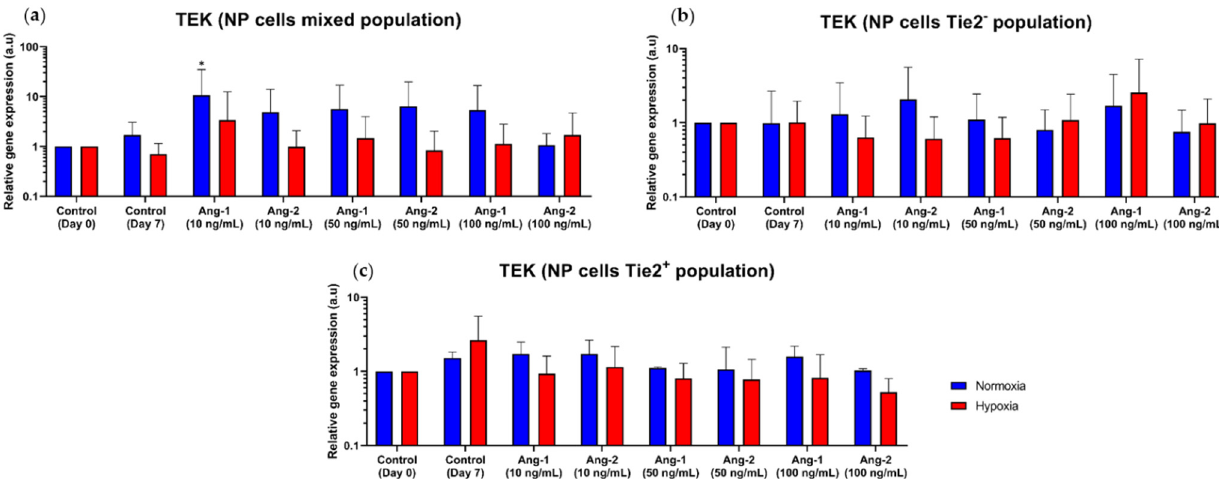
Figure 6. Relative gene expression of the three NP cells populations, comparing the effect of Ang-1/2 at different concentrations in normoxia and hypoxia on the TEK gene expression. The control (Day 0) samples were used as reference (set at 1). Ang-1 and Ang-2 were administrated in three concentrations: 10, 50 and 100 ng/mL. ( a ) TEK relative gene expression of NP cells mixed population; ( b ) TEK relative gene expression of NP cells Tie2 − population; ( c ) TEK relative gene expression of NP cells Tie2 + population. Bars represent mean ± SD. A p -value < 0.05 was considered significant. Asterisks within figures denote the degree of statistical relevance observed: * < 0.05.